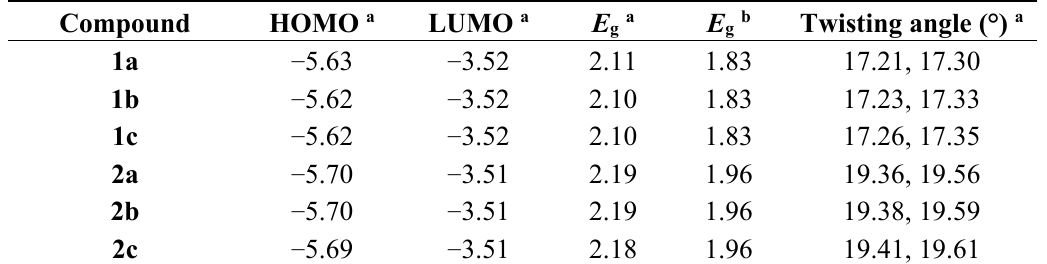
Table 3. Calculated and experimental parameters for 1,7- and 1,6-diamino-substituted PTCDs.